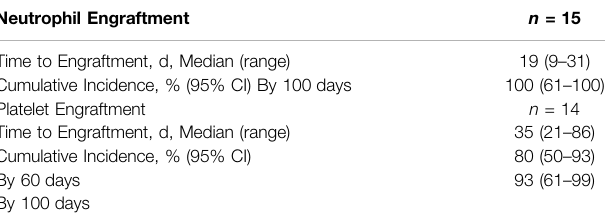
Frontiers in Cell and Developmental Biology |